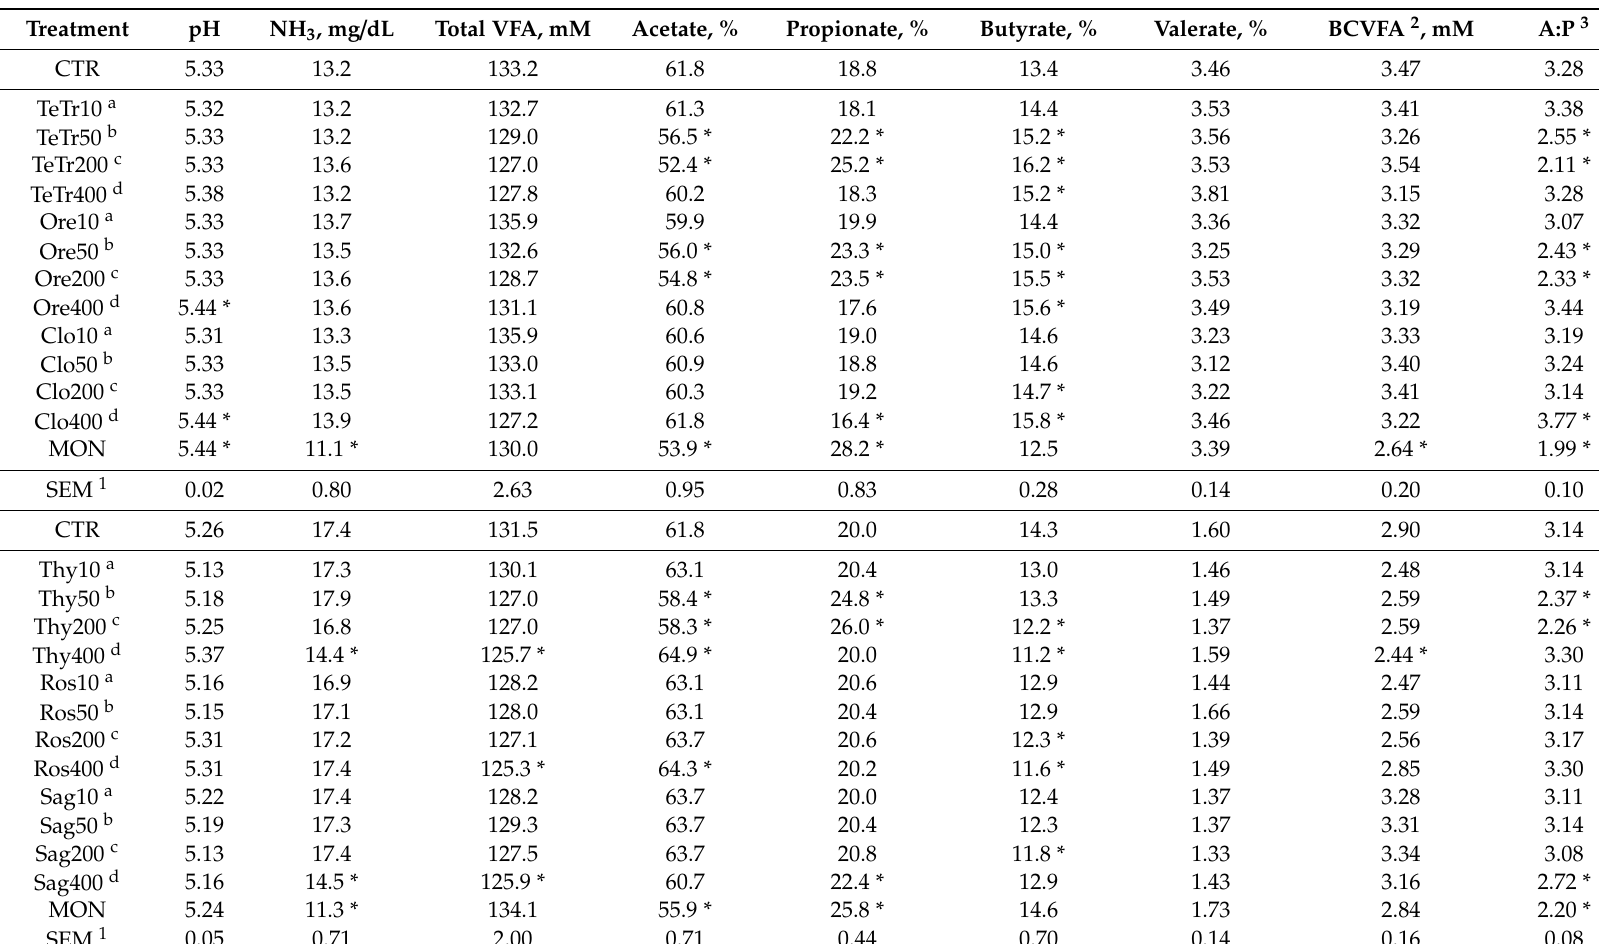
Table 2. E ff ect of Tea Tree (TeTr), Oregano (Ore), Clove bud (Clo), Thyme (Thy), Rosmarinus o ffi cinalis (Ros), Sage oil (Sag) and Monensin (MON) on pH, ammonia-N and total and individual VFA concentrations in vitro fermentation of 10:90 forage to concentrate diet ( n = 6).